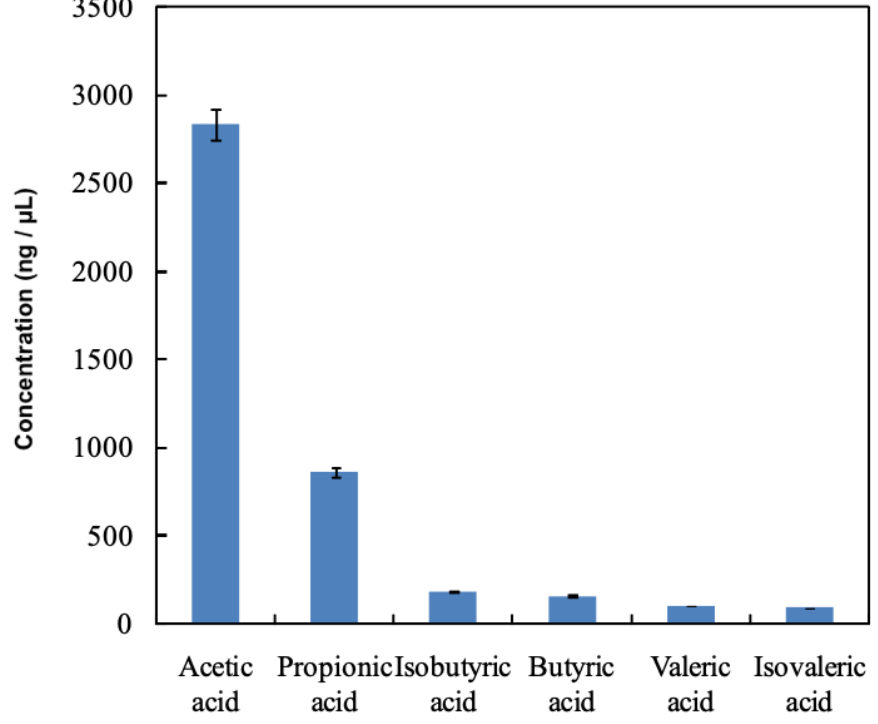
Figure 1. Volatile fatty acid concentration in rumen fluid using the conventional method.